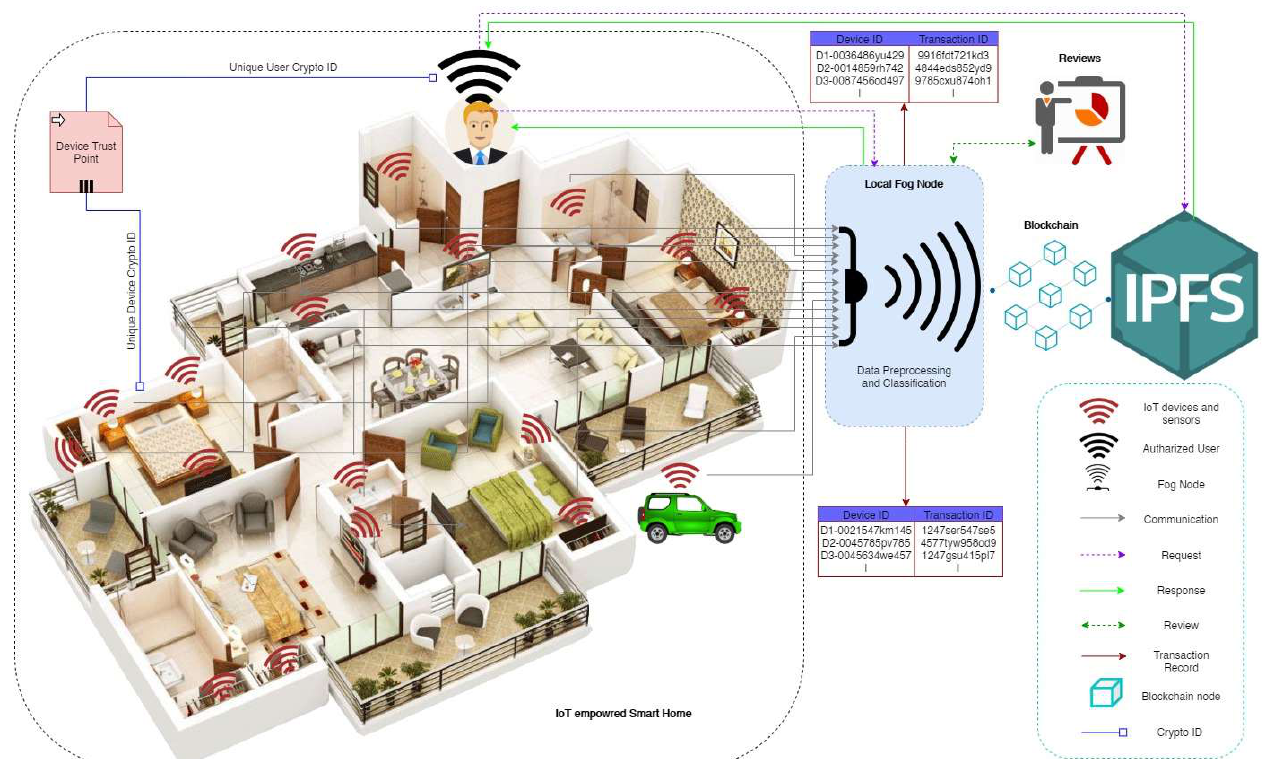
Figure 3. A conceptual framework for IoT and blockchain-empowered smart home.